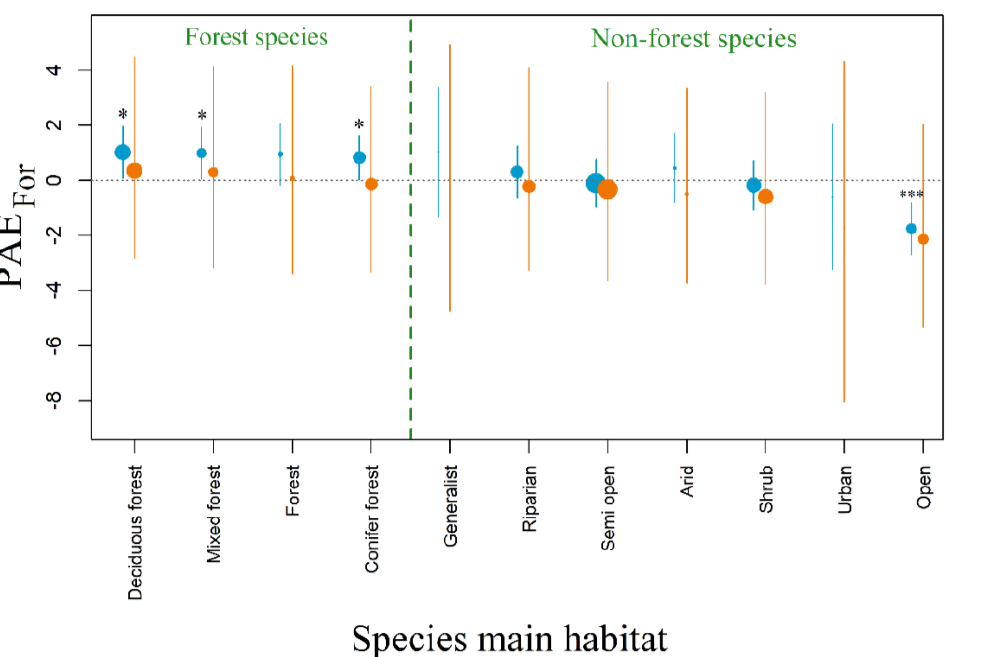
Figure 2: Estimated effect of Protected Areas on species within forest routes (PAE For ) per species’ main habitat, estimated with a linear model (blue) and a phylogenetic linear model with Brownian motion (orange). Estimates were all calculated with species’ populat ion trend and human-affinity fixed to zero. Error bars represent 95% CI; dot sizes are proportional to the number of species in each habitat group. Stars indicate significant effects for the particular model, for the particular species’ main habitat (P: 0. 05 < * < 0.01 < ** < 0.001 < ***). Habitat types are ordered from the highest to the lowest PAE For values under the phylogenetic